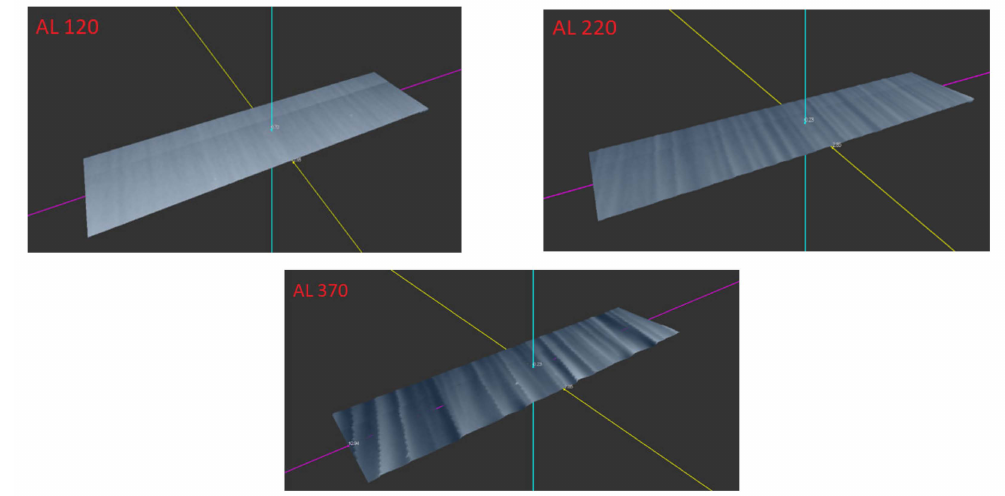
Figure 11. 3D model of the scanned EN5083 samples.